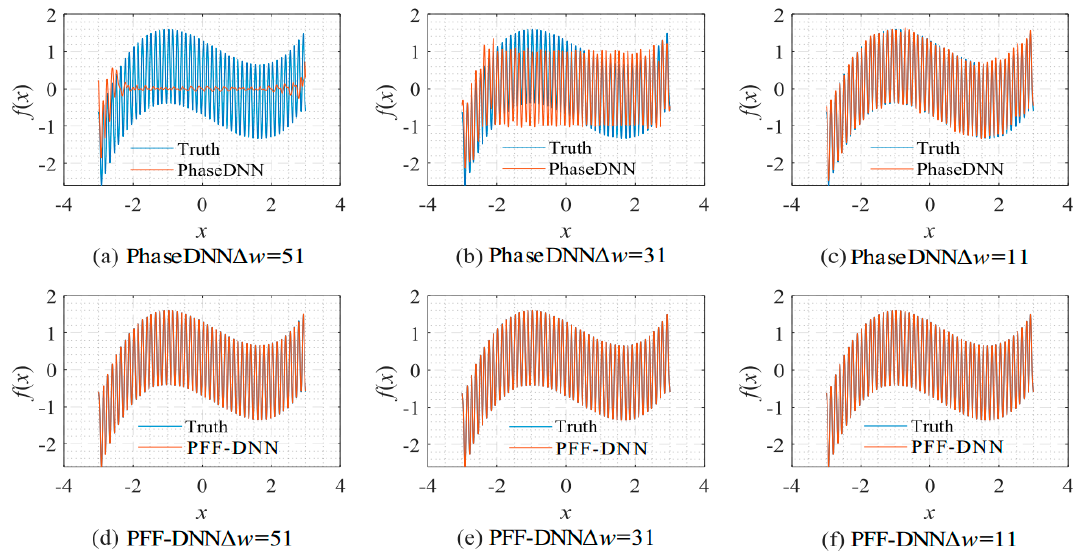
Figure 8. The influence of Δ ω on the algorithm performance. The fitting results of the PhaseDNN method after 10,000 updates: ( a ) Δ ω = 51; ( b ) Δ ω = 31; and ( c ) Δ ω = 11. The fitting results of the PFF-DNN method after 10,000 updates: ( d ) Δ ω = 51; ( e ) Δ ω = 31; and ( f ) Δ ω = 11.